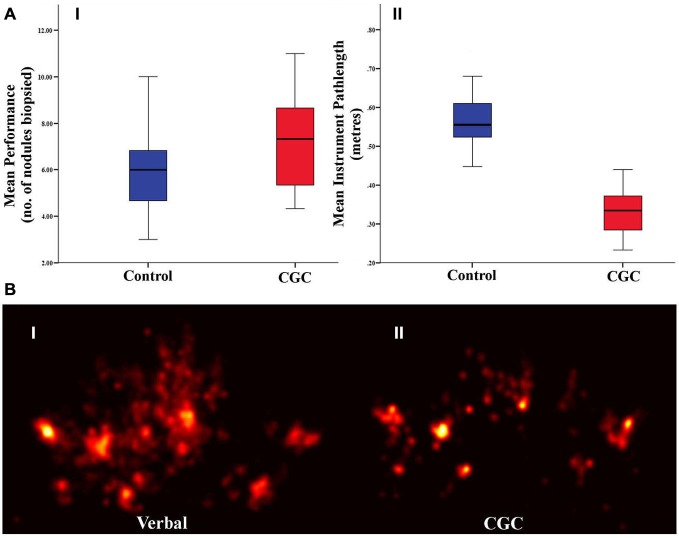
(A) Technical performance as indexed by the number of biopsies retrieved (I) and instrument path length (II). Box plots indicate mean and error bars represent 95% confidence interval. (B) Gaze plots from a representative subject under control (I) and gaze guidance (II) demonstrate more focussed fixations during gaze-assistance.